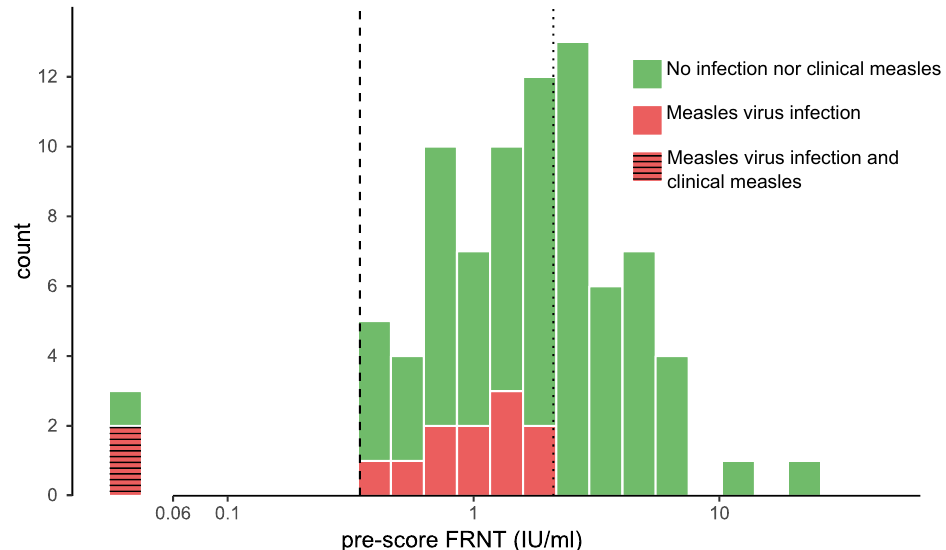
Figure 2. Distribution of FRNT log antibody concentrations at the first sampling in participants excluding those with evidence of measles virus (MV) infection prior to the first sample ( n = 83) taken shortly after the onset of a measles outbreak in the Netherlands, 2013–2014. Colors indicate MV infection status. The vertical dashed line depicts the correlate of protection against measles (0.345 IU / mL) and the vertical dotted line the correlate of protection against MV infection (2.06 IU / mL). Three children had antibody concentrations below the lower limit of detection (0.06 IU / mL). FRNT: focus reduction neutralization